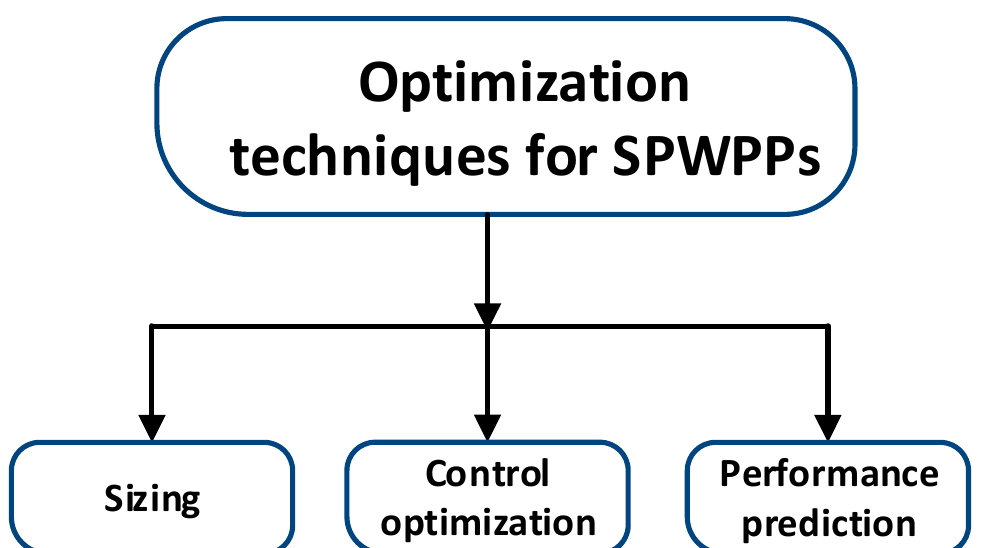
Figure 9. The main optimization techniques for solar-powered water pumping plants.